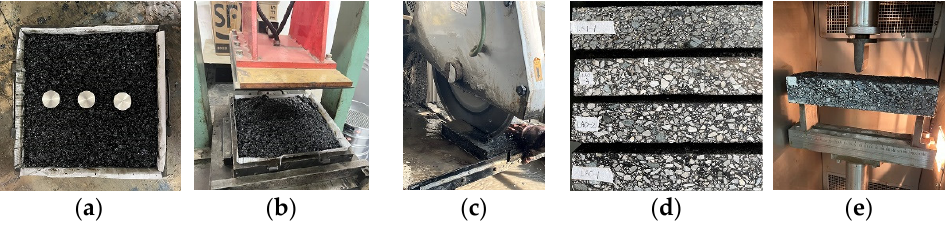
Figure 4. Beam specimen preparation. ( a ) Sensor positioning; ( b ) rutting plate specimens; ( c ) cutting of specimens; ( d ) beam specimens marking; ( e ) a three-point bending test.